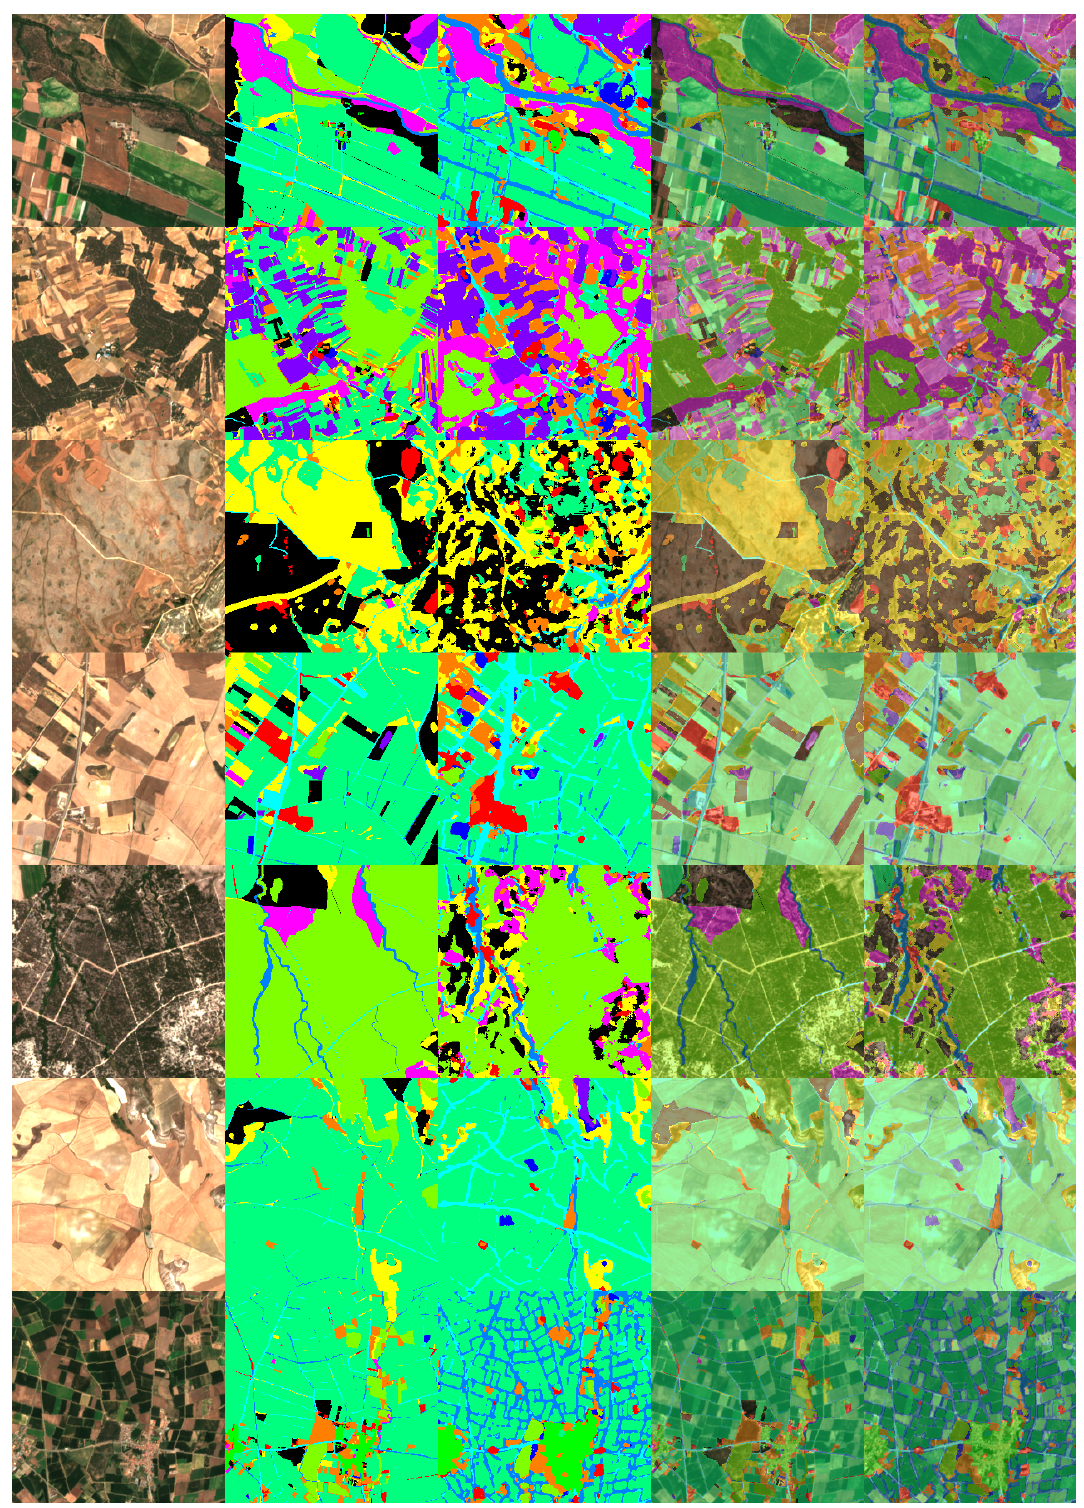
Figure 15. Visualization of the predicted results for UNet evaluated in UOS2 with “Other” class (Experiment All-Purpose). ( 1st col. ) Original images, ( 2nd col. ) ground truth masks, ( 3rd col. ) predictions, ( 4th col. ) overlapping of original images with ground truth masks, ( 5th col. ) overlapping of original images with